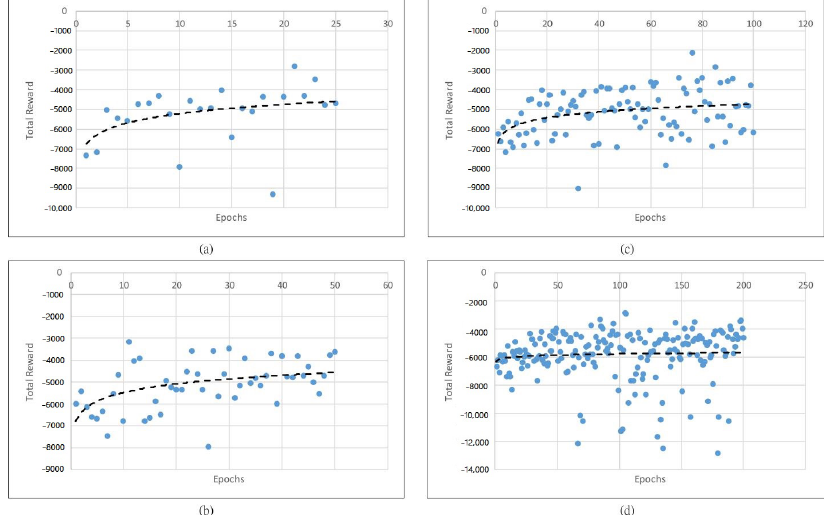
Figure 10. Total reward while training using action time step 1 s with epochs ( a ) 25 ( b ) 50 ( c ) 100